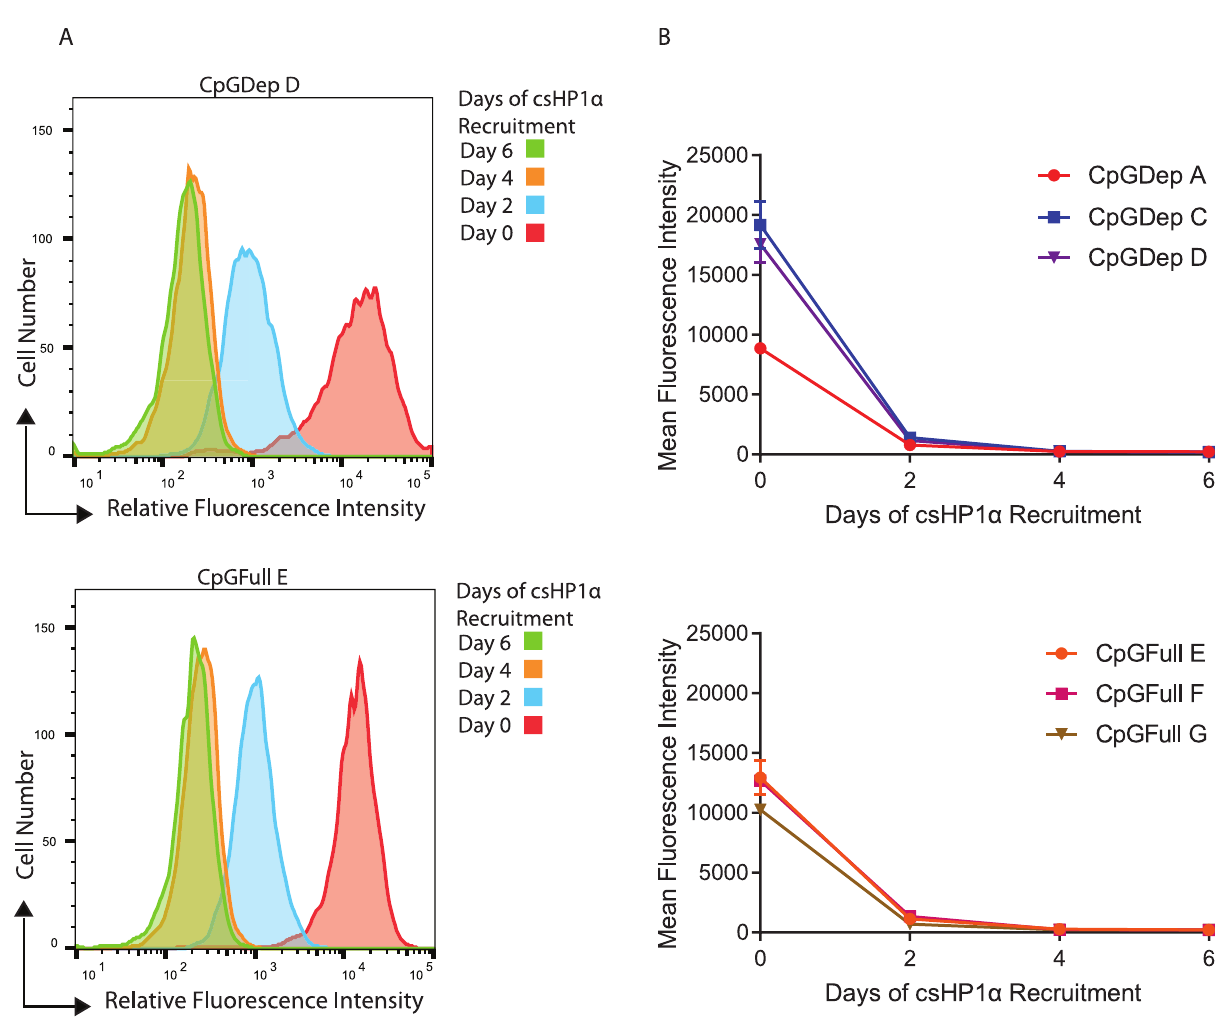
Fig 2. Recruitment of csHP1 α induces silencing of GFP expression. A) Representative histograms show reduction of relative GFP levels as measured by flow cytometry in CpGDep D and CpGFull E cell lines during csHP1 α recruitment. B) Mean fluorescent intensities of CpGDep and CpGFull clonal cell lines during csHP1 α recruitment, averages of three biological replicates on Attune